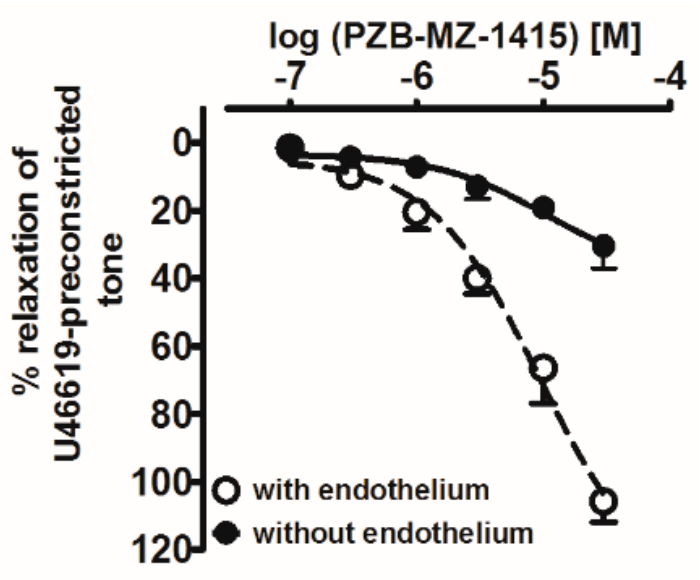
Figure 1. Influence of endothelium removal on the vasorelaxation induced by PSB-MZ-1415 in isolated human pulmonary arteries. Results are expressed as the percentage relaxation of the isometric contraction induced by U46619 ( n = 3 per group) in comparison to the respective